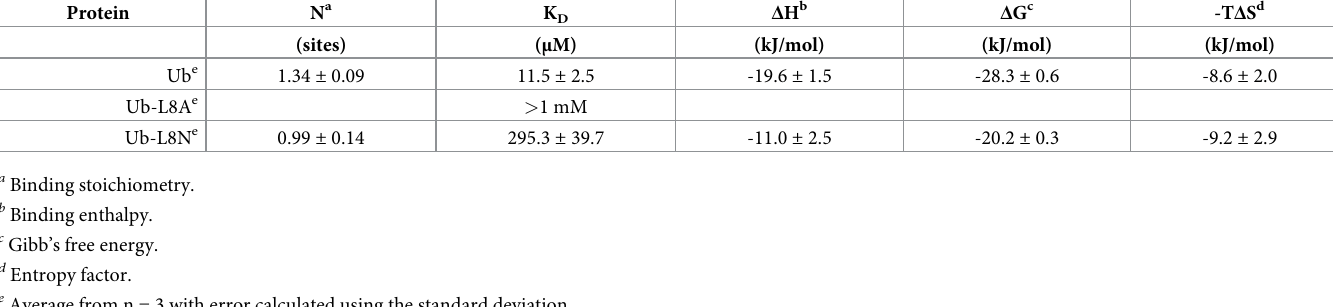
Table 2. Isothermal Titration Calorimetry of TAGV-Ub binding.